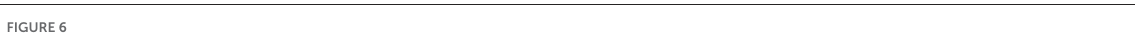
FIGURE6 DG of mice at PND 14 after adenovirus injection (ADV-GFP-Con vs. ADV-GFP-L-Pro, p < 0.001, ADV-shPGC-1 α -Con vs. ADV-shPGC-1 α -L-Pro, p = 0.334. ADV-GFP-Con vs. ADV-shPGC-1 α -Con, p = 0.004. N = 3). Scale bar, 50 µ m. Error bars, mean ± SD. *** (ADV-GFP-Con vs ADV-GFP-L-Pro): p < 0.001; ## (ADV-GFP-Con vs. ADV-shPGC-1 α -Con): p < 0.01. One-way ANOVA followed by an LSD test was used for